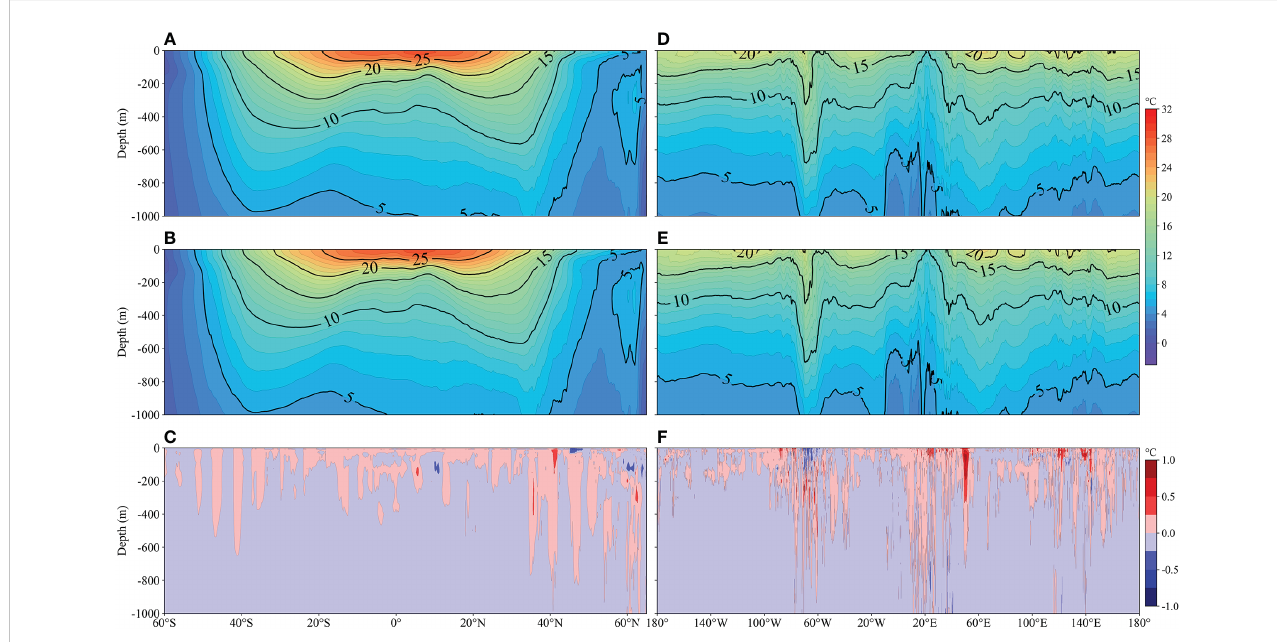
FIGURE 10 Longitudinal averaged climatic (1995~2017) sea temperature pro fi les along latitudinal direction of (A) ODF-ST dataset, (B) WOA18, (C) their difference and longitudinal direction of (D) ODF-ST dataset, (E) WOA18, and (F) their